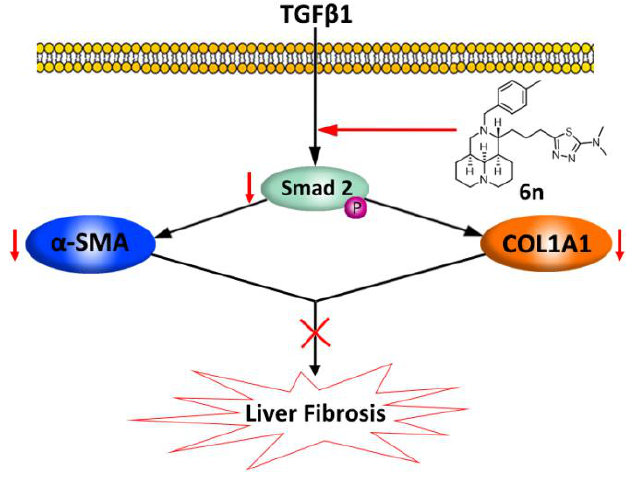
Figure 4. Compound 6n exerted the anti-liver fibrotic activity via repressing the Smad/TGFβ pathway.